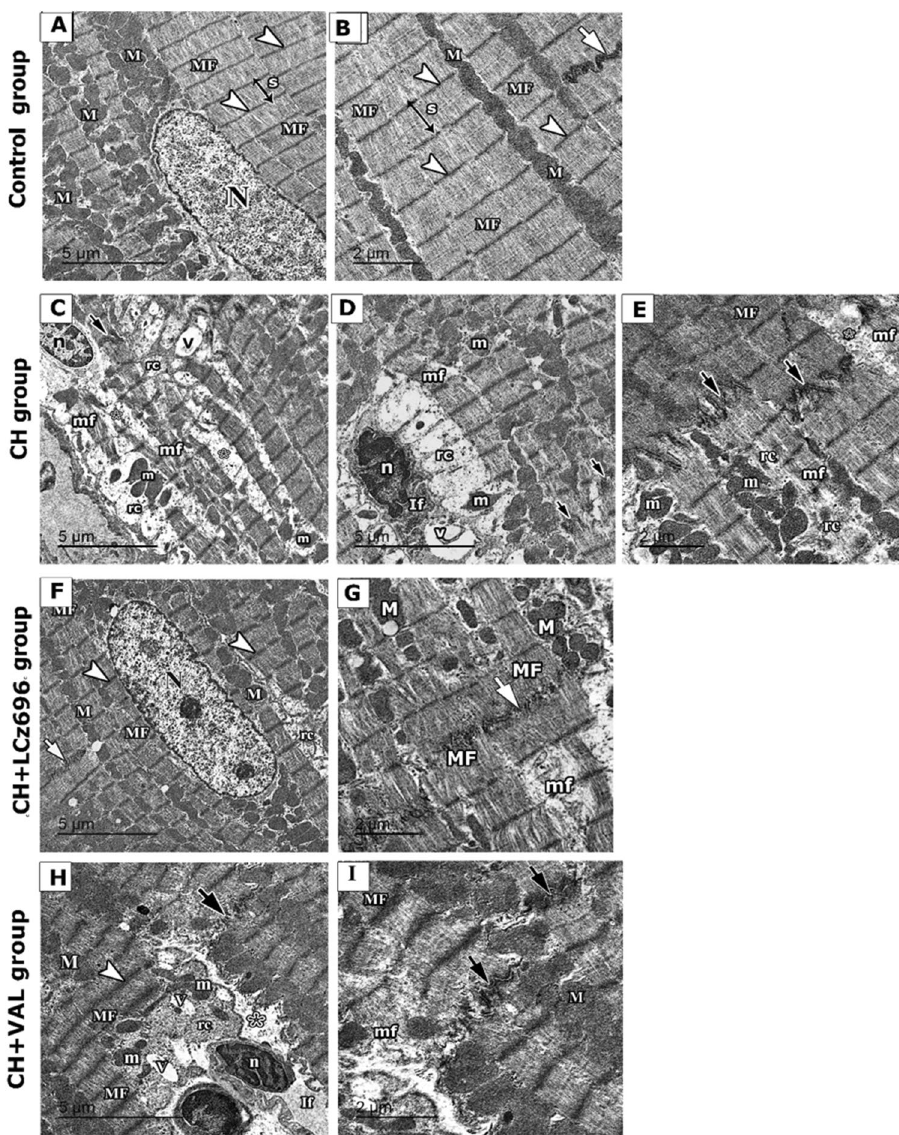
Figure 6. Electron micrographs of ultrathin sections in left ventricles of different experimental groups. ( A , B ) Control group showing myofibrils (MF) with narrow interfibrillar space. The oval euchromatic nucleus is seen in one fiber (N). Regular arrays of myofibrils are closely arranged within sarcomere (s) from Z line to Z line (arrowhead). Abundant mitochondria (M) were typically intact and neatly arranged in rows between the myofibrils. An intact intercalated disc can be seen in between the myofibril (short white arrow). ( C – E ) CH group showing cardiomyocyte with waviness and disturbed myofibrils (mf) with rarefied cytoplasm (rc) and heterochromatic nucleus (n). Wide separation between the myofibrils (*), many distorted and irregularly arranged mitochondria of different sizes and shapes (m), and areas of cytoplasmic vacuolations (V) can be observed. The interstitial tissue space is widened with infiltrating cells (If) that have a heterochromatic elongated nucleus (n). A distorted intercalated disc (short black arrow) can be noticed. ( F , G ) CH + LCZ696 group exhibited cardiomyocytes with a euchromatic nucleus (N) and nucleolus, regular transverse striations of myofibrils (MF) with regular (Z) lines (arrowhead). Rows of nearly normal mitochondria (M) are regularly arranged in between the myofibrils (MF) with an intact intercalated disc (short white arrow) can be seen. Area of rarefied cytoplasm (rc) can be noticed. ( H , I ) CH + VAL group reveals that some areas show regular transverse striations of myofibrils (MF) with regular (Z) lines (arrowhead). Rows of nearly normal mitochondria (M) are regularly arranged in between the myofibrils (MF). Other areas reveal separation between the myofibrils with rarefied cytoplasm (rc), some distorted and irregularly arranged mitochondria of different sizes and shapes (m), and areas of cytoplasmic vacuolations (V). The interstitial tissue space is widened with infiltrating cells (If) that have a heterochromatic irregular nucleus (n). A distorted intercalated disc (short black arrow) can be